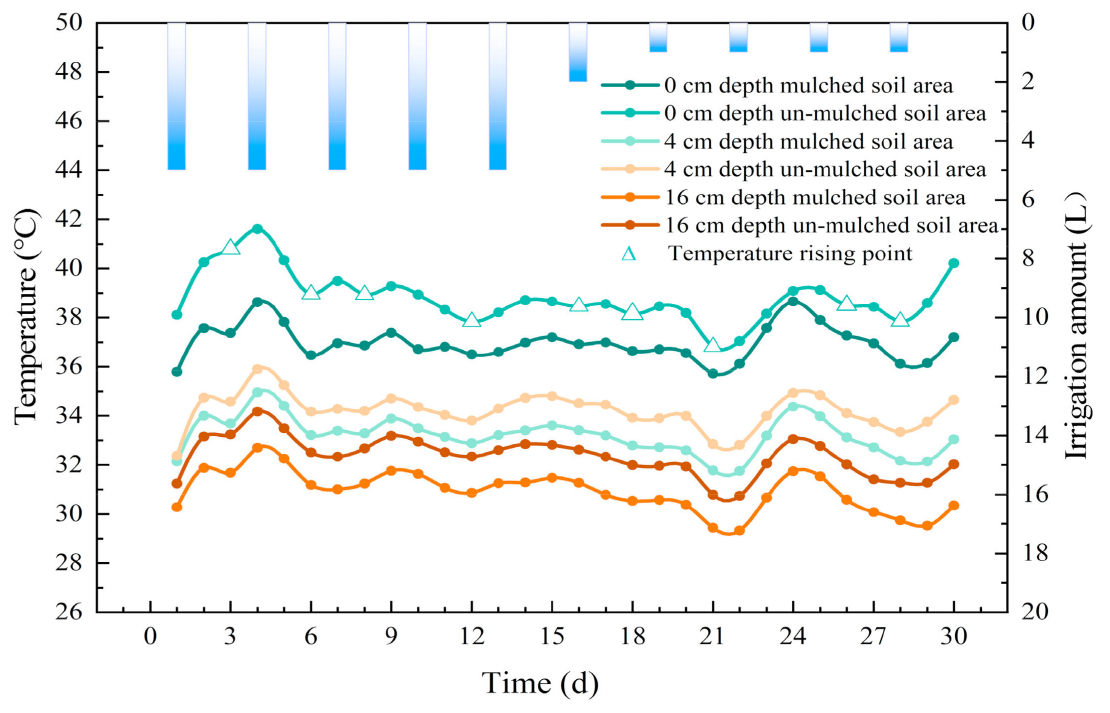
Figure 12. The daily mean temperature of soil at different depths and mulched conditions during the entire period for